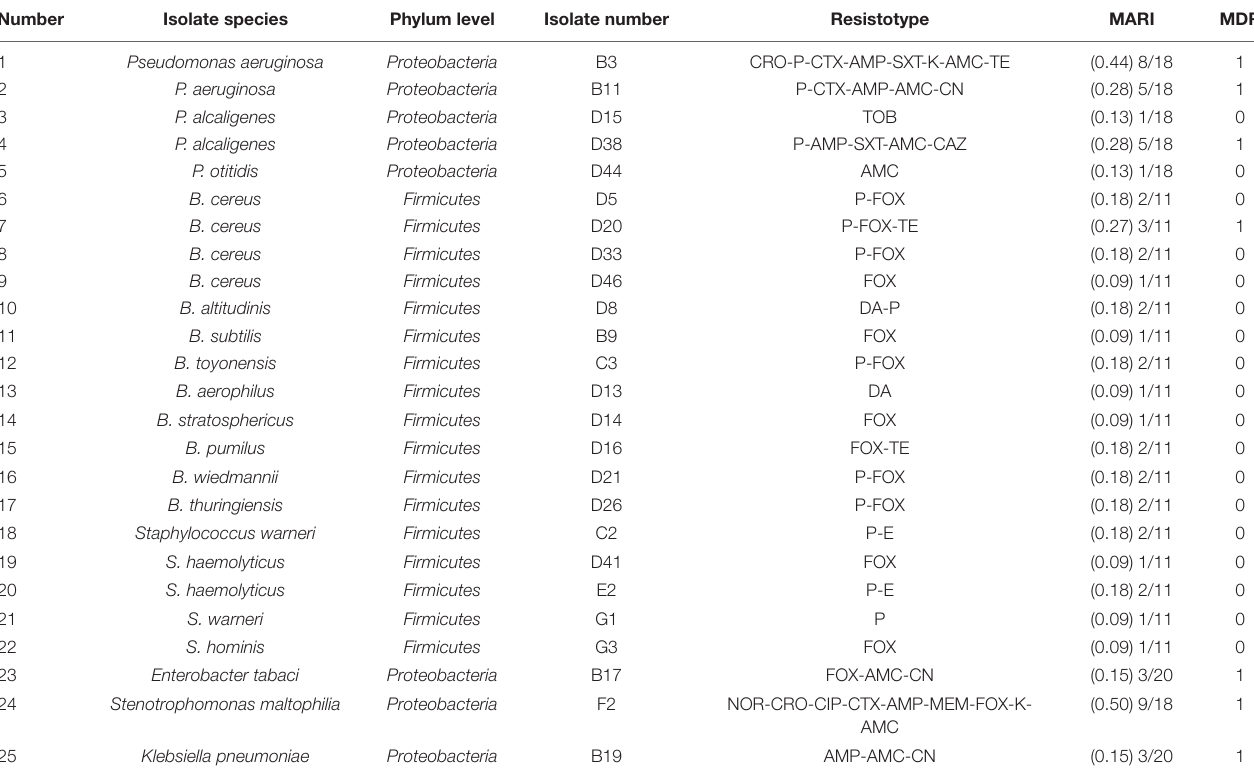
TABLE 2 | Antibiotic resistance profiles of the selected species isolated from the DWTS. Number Isolate